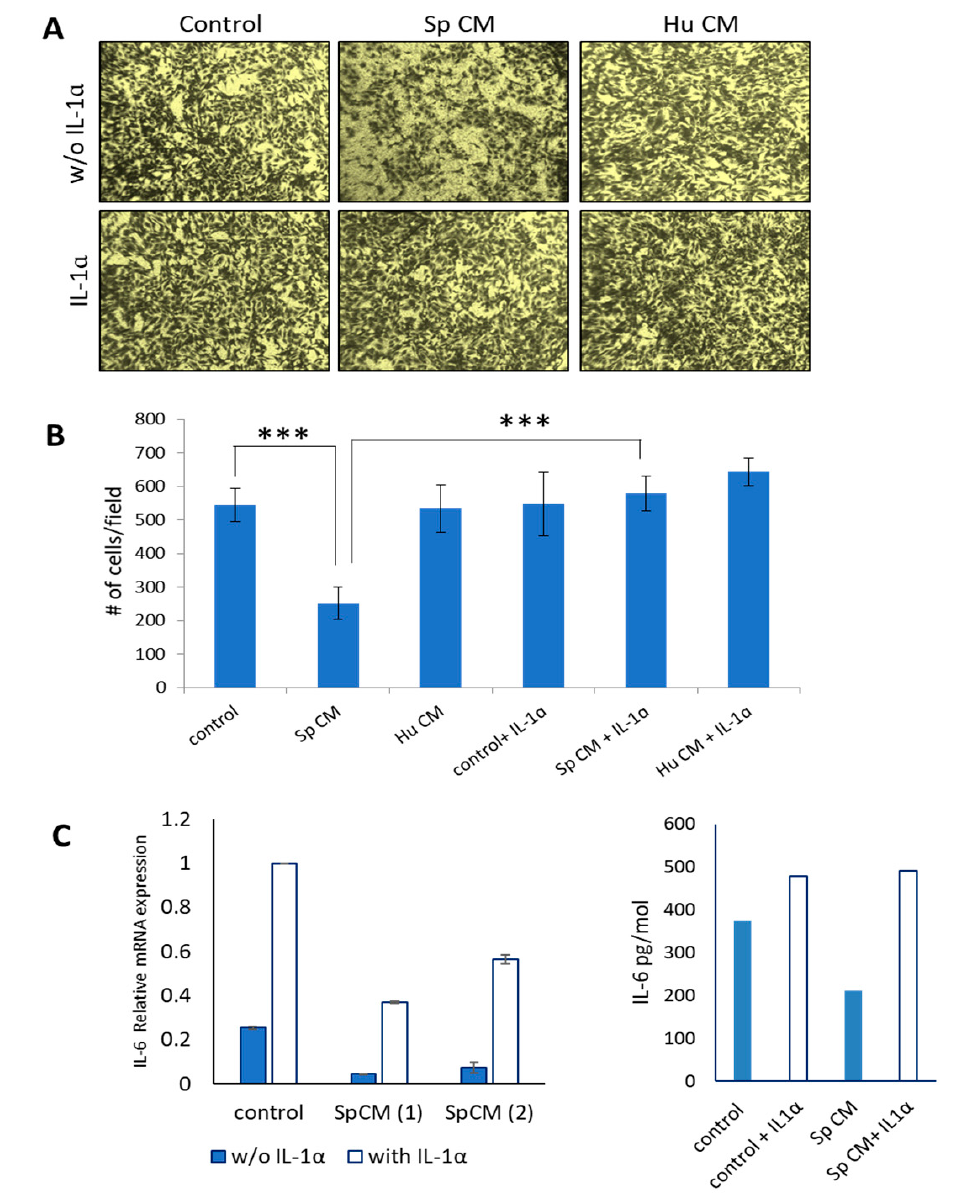
Figure 7. Recombinant IL1 α agonist restores cancer cell migration when added to MDA-MB-231 cells exposed to Spalax CM. ( A ) Transwell ® migration assays: CMs of Spalax (Sp) and human (Hu) fibroblasts with/without of 50 ng/mL recombinant IL-1 α were added to the lower chamber; suspen- sion of MDA-MB231cells (1 × 10 5 ) in 500 µ L of RPMI were added to the upper chamber. Migrated MDA-MB-231 (adhered to the lower surface of the Transwell ® membranes with an 8 µ m-pore size) were photographed after incubation for 24 h at 37 ◦ C. ( B ) Migrated cells were calculated using Image J software in four independent view fields per insert. Experiments were performed in triplicate and repeated 3 times. Data are presented as mean ± SD (n = 3), *** p ≤ 0.001 differences between number of migrated MDA-MB-231 under effects of Spalax CM versus control, and between effects of SpCM+IL-1 α versus SpCM alone. ( C ) MDA-MB-231 were incubated for 4 days with CM from senescent Spalax fibroblasts with/without recombinant IL-1 α (50 ng/mL), thereafter cells were either collected for mRNA determination or washed and incubated for further 24 h in fresh serum-free media, then the IL6 ELISA was applied. Spalax . CMs (1) and (2) are the senescent secretome received from fibroblasts isolated from different Spalax individuals. # means the